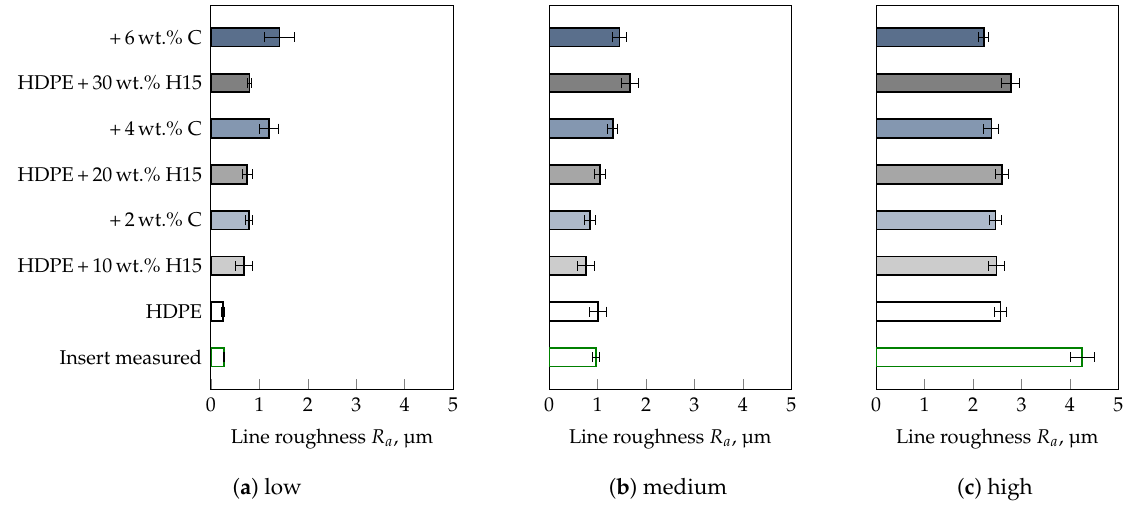
Figure 7. Influence of filler Plustalc H15 (H15, D 50 = 5.4 µ m), and compatibilizer (C) content on the impression quality. Deployed insert with a target line roughness of ( a ) 0.2 µ m (low), ( b ) 0.8 µ m (medium), and ( c ) 3.2 µ m